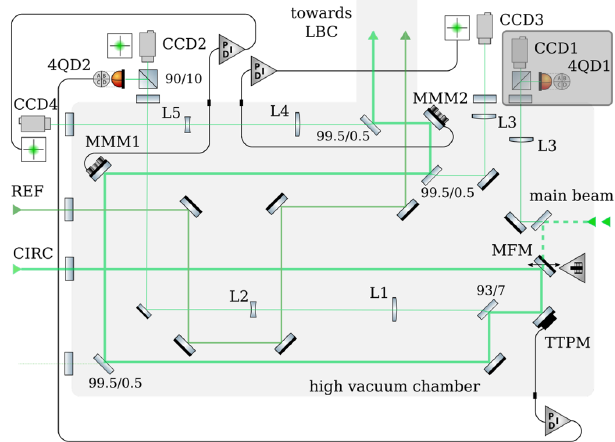
FIG. 14. Optical setup and laser beam path in the injection box vacuum chamber used to dispatch the laser beams in the LBC and towards diagnostic tools. MFM: motorized high accuracy flip mirror, TTPM tip/tilt piezo mirror. MMM1,2: piezo-motorized mirrors. 4QD1,2: 4 quadrant position detectors. L1, L3, L4: plano-convex lenses. L2, L5: plano-concave lenses (See text for details).